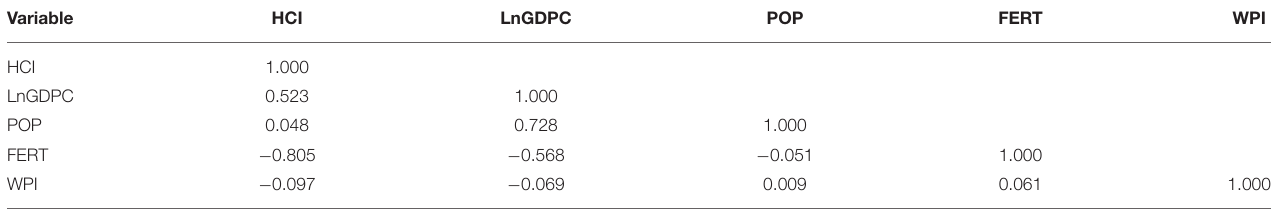
TABLE 2 | Pairwise correlations.